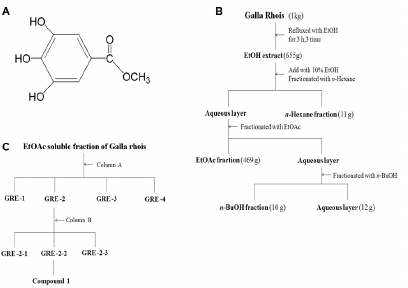
Figure 1. Isolation of methyl gallate from Gallarhois . (A) Chemical structure of methyl gallate, (B) Procedures of extraction and fraction of the Galla Rhois , (C) Column chromatographic procedures of n-EtOAc fraction.